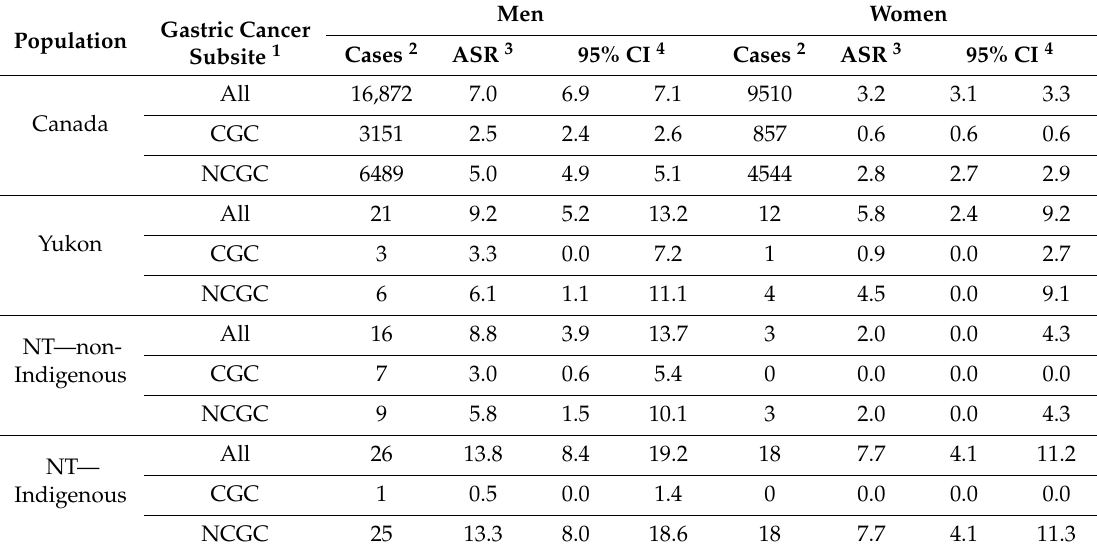
Table 3. Estimated gastric cancer age-standardized incidence rates (ASRs per 100,000) by subsite, population, and sex; northern territories and Canada; various